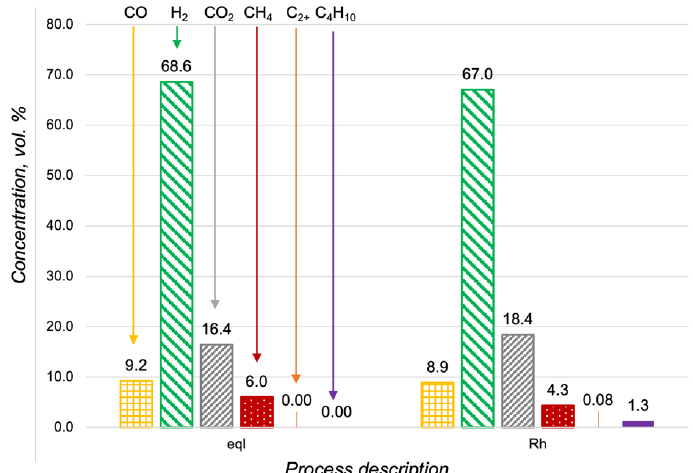
Figure 9. Hydrocarbon content in the products of the n-butane steam reforming at 600 °C, with H 2 O/C = 3 and O 2 /C = 0.5 in a thermodynamic equilibrium (eql) and over the Rh/CZA/FeCrAl at GHSV = 8125 h −1 .